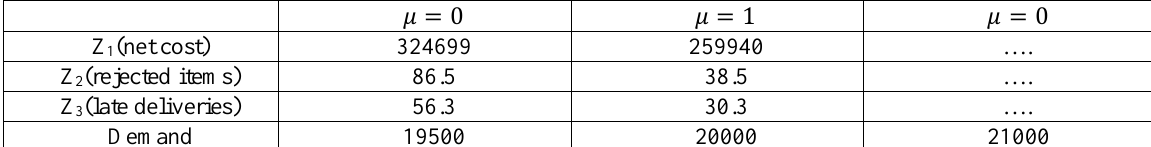
Table 2. The data set for membership